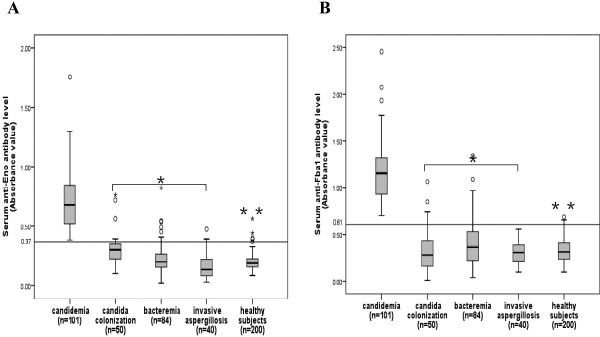
Antibody levels in study patients (A: anti-Eno and B: anti-Fba1). Patients with candidemia, Candida colonization, bacteremia, invasive aspergillosis and healthy controls were evaluated for the presence of anti-Eno and anti-Fba1 antibodies. The levels of anti-Eno and anti-Fba1 in patients with candidemia were higher than control groups. Boxes indicate interquartile ranges (25–75th percentiles). Horizontal bars in bold indicate the median value in each group. Whiskers extend to 1.5 times the interquartile range. *P < 0.001, for the comparison with the patients with candidemia; **P < 0.001, for the comparison with the patients with candidemia.